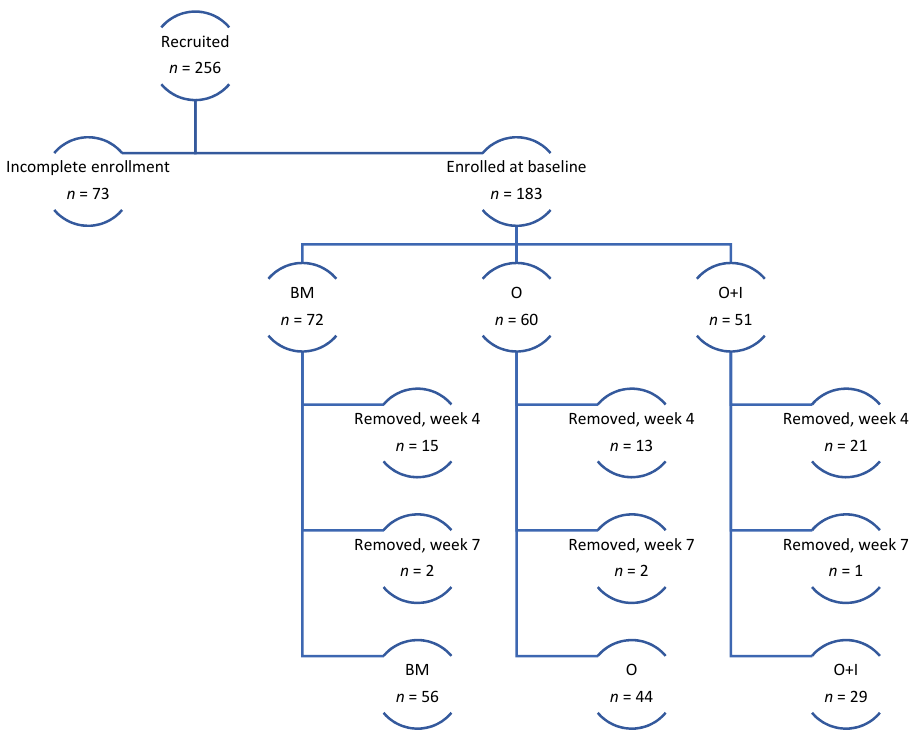
Figure 1. Study design and enrollment. BM = brick-and-mortar control; O = online-only; O+I = online + intervention content.